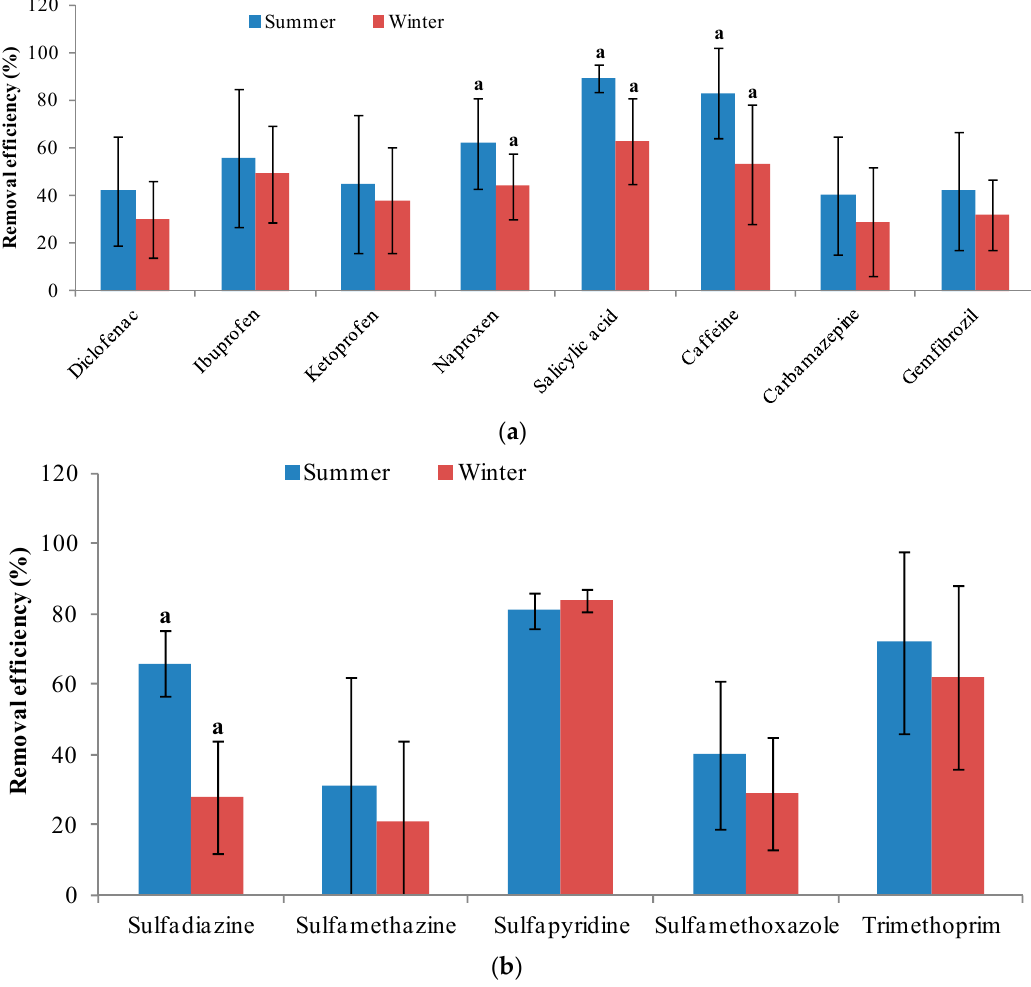
Figure 2. The removal efficiency (mean and standard deviation) of PhCs with different types of CWs in different seasons. Note: ( a ) For naproxen, salicylic acid, and caffeine “ a ” shows the significant difference in the removal efficiency during summer and winter at α = 0.05 ( p < 0.05). ( b ) For sulfadiazine, “ a ” shows the significant difference in the removal efficiency during summer and winter at α = 0.05 ( p < 0.05). The number of observations of studied PhCs for seasonal effect is given in Table S9 (Supplementary Materials). Negative values in the case of standard deviation were capped at zero to improve the readability of the graph. Actual values (e.g., below zero) can be found in Table S9 (Supplementary Materials).